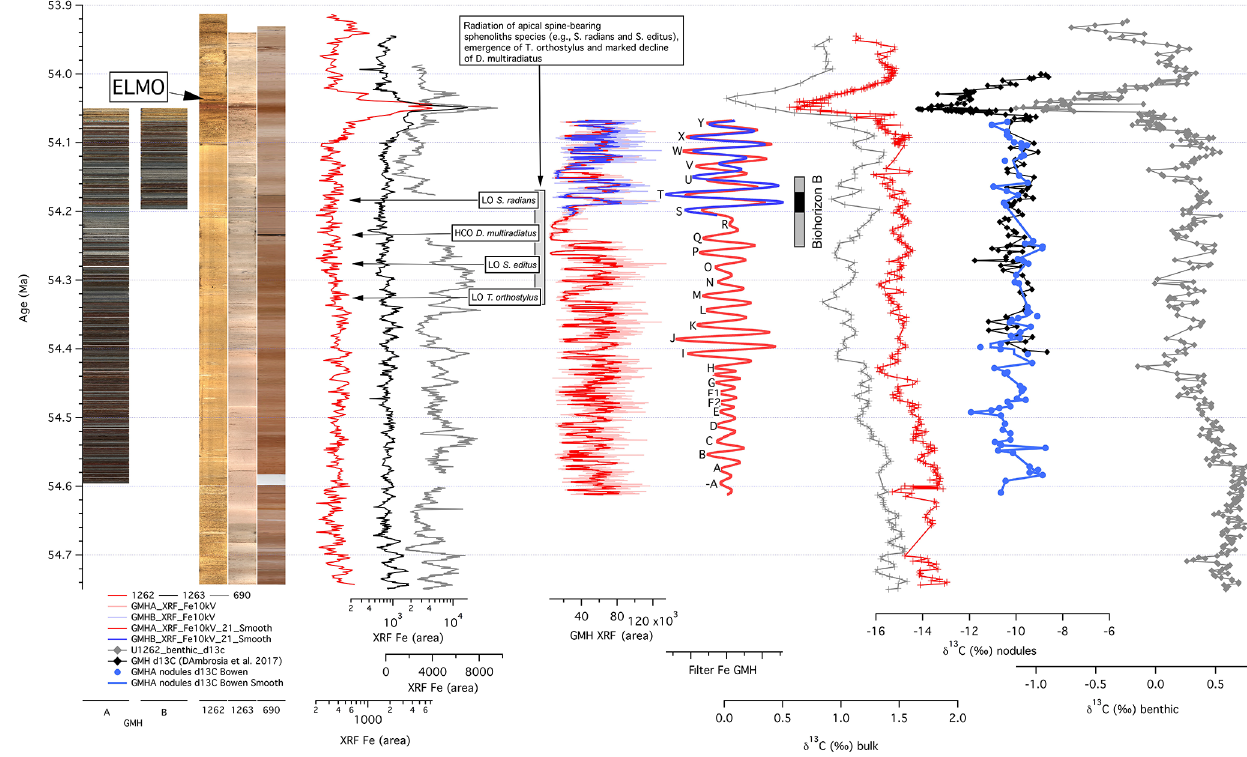
Figure 8. Overview of data for the interval prior to the Eocene Thermal Maximum 2 (ETM-2) from deep-sea records and the terrestrial Gilmore Hill (GMH) drill core against age. Core images for GMH-A and B, core images of ODP Sites 1262, 1263, and 690 (aligned from left to right according to the water depth from deep to shallow), XRF Fe core scanning data from 1262 (red), 1263 (black), 690 (grey) (Westerhold et al., 2007), and GMH, extracted Gaussian filter of the GMH XRF Fe intensity data, stable carbon isotope data of soil nodules from the Gilmore Hill area (black – Gilmore Hill section; Abels et al., 2012, and D’Ambrosia et al., 2017; blue – GMH drill core), and the deep-sea benthic foraminifera (1262 – Littler et al., 2014) and bulk sediment (690 – Cramer et al., 2003; 1262 – Zachos et al., 2010). Position of Biohorizon B is after Abels et al., 2012, and D’Ambrosia et al., 2017 (black bar represents best estimate; gray bars represent conservative estimate – see text for discussion); the change in calcareous nannofossils (gray bar and text box) at ODP Site 1262 from Agnini et al.